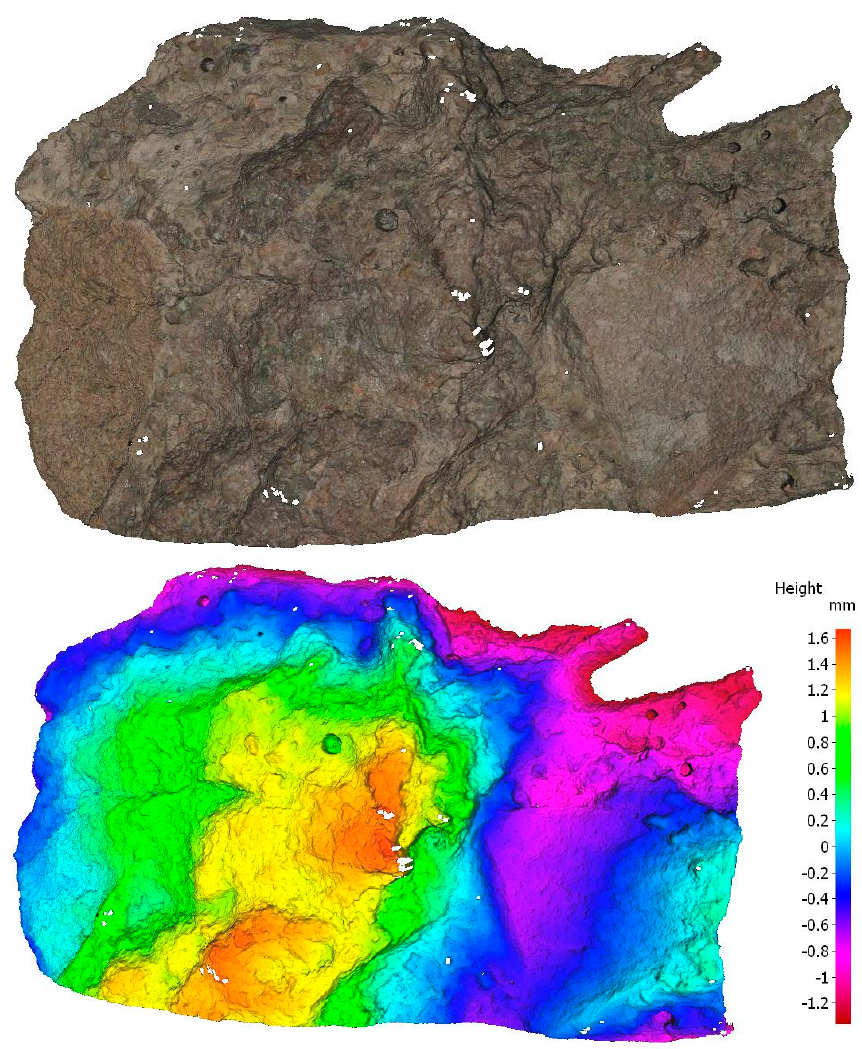
Figure 1. RCA scanning by infinite focused microscope.